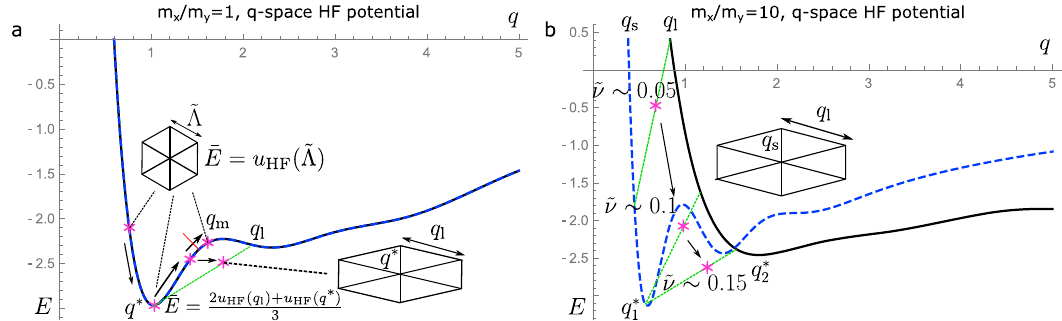
-- E with respect to the partial fi lling ~ ν . The curves represent the Hartree – Fock (HF) interaction potential Fig. 3 The evolution of the repulsion energy u E in units of e 2 / l and q in units of 1/ l , where l is the magnetic length. The snow fl ake represents the average (cid:2) E between the origin and its six HF (q) with nearest neighbours in the reciprocal lattice. a Isotropic case. The arrows show how (cid:2) E evolves with increasing ~ ν . At small ~ ν , the lattice adopts a triangular shape with the average repulsion energy u HF ð ~ Λ Þ . When ~ ν increases, two of the six nearest neighbours have a tendency to stay at a distance q * , while the other four are repelled away from the origin, staying at a distance q l . The green line roughly indicates the average repulsion from q l and q * . As ~ Λ is approaching q m , a stretched lattice becomes more and more favoured and eventually causes a transition in the lattice shape from the triangular lattice. b Under large mass ratio m x / m y = 10. The dashed/solid curve corresponds to the interaction along the y / x -direction. When ~ ν increases, two of the six nearest neighbours soon fall to the distance q (cid:4) . The crystal then evolves with this distance fi xed while the other four nearest neighbours move away. The 1 state becomes a stripe crystal phase through a continuous phase transition, or even crossover without